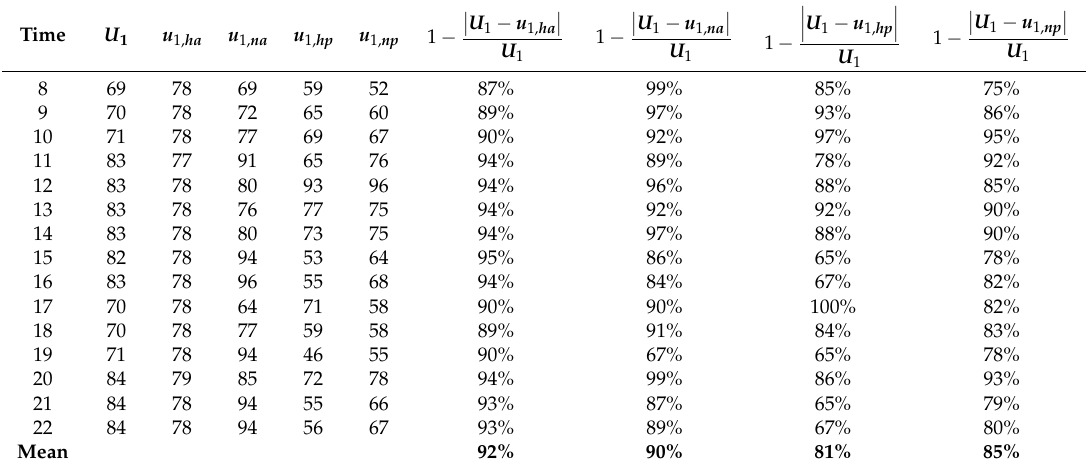
Table 6. The accuracies of vehicle speed estimation of the road segment covered by Cell 1 .